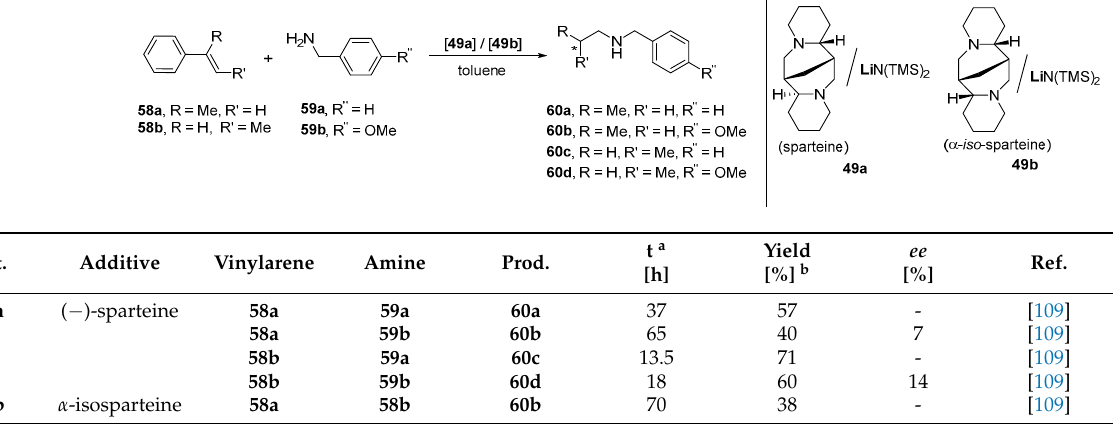
Table 15. Catalytic asymmetric intermolecular hydroamination of vinylarenes 58a , b with amines 59a , b using the chiral lithium catalytic system 49a , b a .